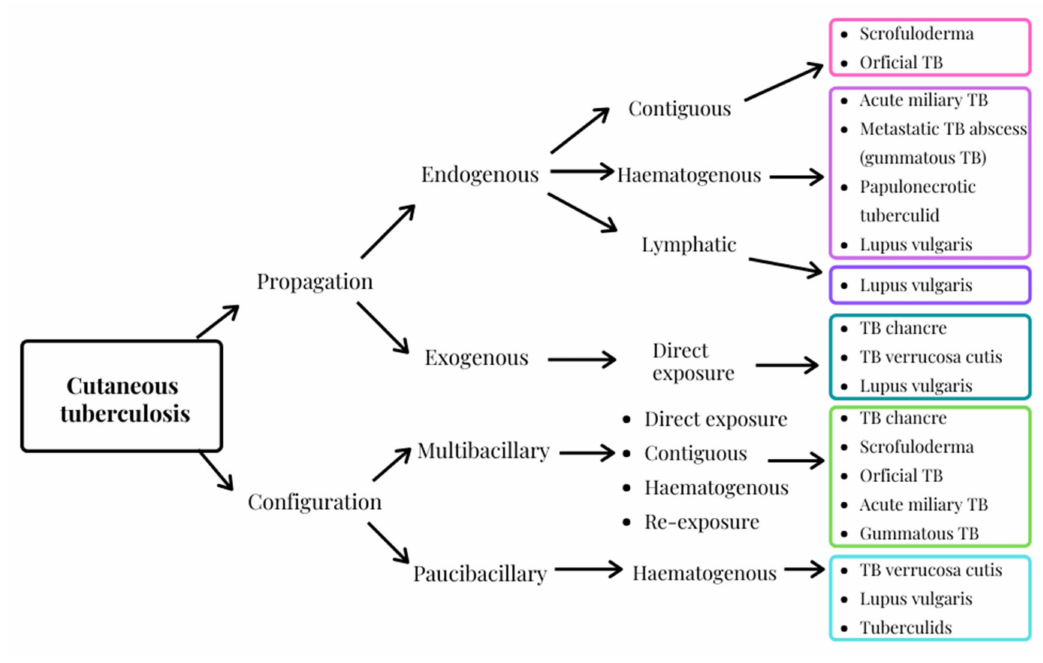
Figure 3. Classification system of CTB (adapted from